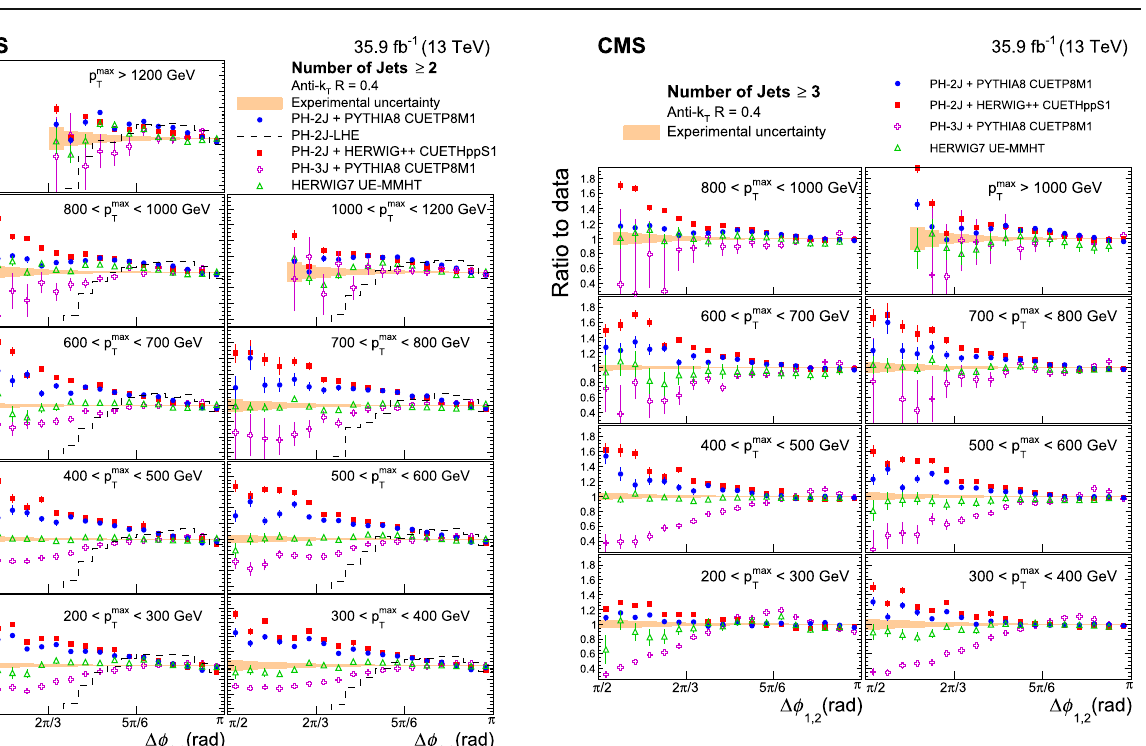
Fig. 8 Ratios of ph- 2j + pythia 8, ph- 2j + herwig++ , ph- 3j + pythia 8, and herwig 7 predictions to the normalized inclusive 3- Fig. 7 Ratios of ph- 2j + pythia 8, ph- 2j- lhe , ph- 2j + herwig++ , jet cross section differential in Δφ 1,2 , for all p max regions. The solid ph- 3j + pythia 8,and herwig 7predictionstothenormalizedinclusive T band indicates the total experimental uncertainty and the vertical bars 2-jet cross section differential in Δφ 1,2 , for all p max regions. The solid T on the points represent the statistical uncertainties in the simulated data band indicates the total experimental uncertainty and the vertical bars on the points represent the statistical uncertainties in the simulated data tions differential in Δφ 1,2 range from 3% at π/ 2 to 0.1% at π . For the normalized 3- and 4-jet cross sections differential The bin width used in the measurements of Δφ 1,2 and Δφ min is set to π/ 36 = 0 . 087 rads (5 ◦ ), which is five to ten in Δφ min 2j times larger than the azimuthal angular separation resolution.